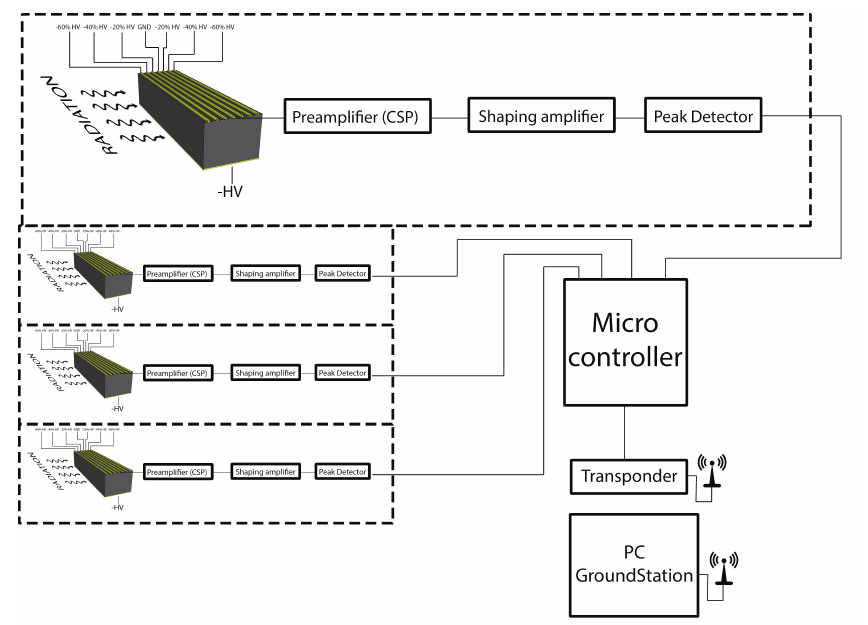
Figure 5. Read out electronic, with charge sensitive preamplifier (CSP), and data transmission